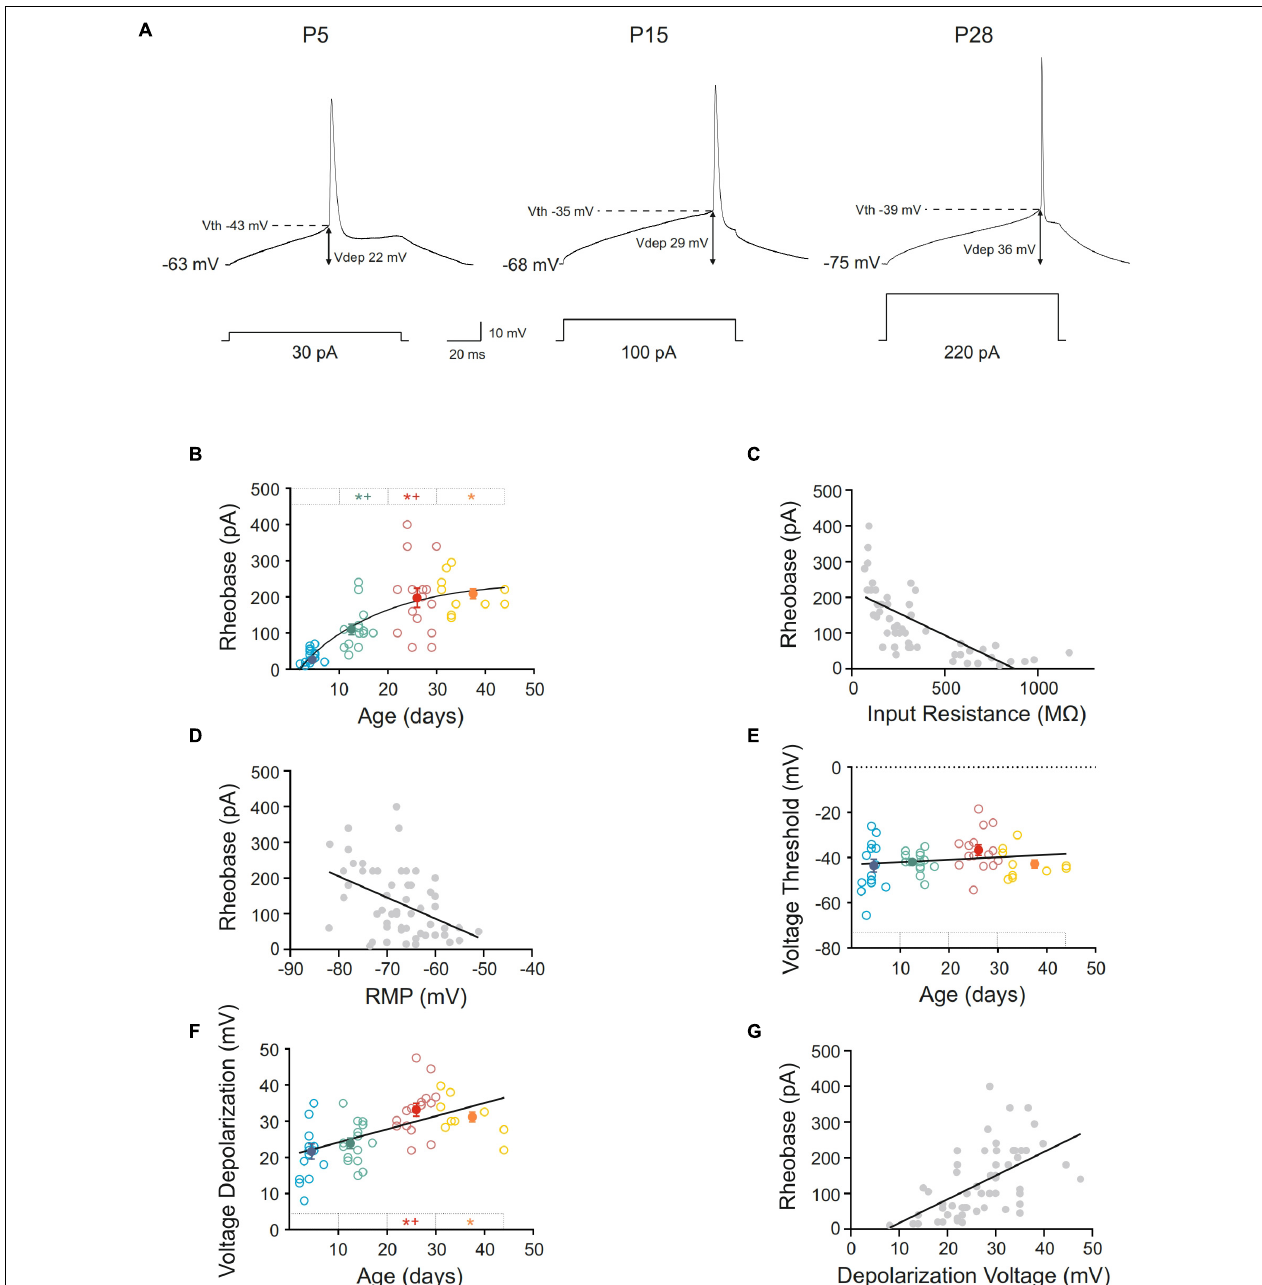
FIGURE 3 | Postnatal development of rheobase and threshold and depolarization voltages of motor cortex pyramidal neurons. (A) Membrane voltage responses to the minimum current (rheobase) required to evoke an action potential in representative neurons of different postnatal ages. (B,E,F) Scatter plots showing the changes in rheobase (B) , voltage threshold (E), and voltage depolarization (F) as a function of postnatal age. Open symbols represent the raw data, while filled symbols are the means of the four different age groups and their standard errors. Each group is represented by a color (blue = newborn, n = 15; green = infantile, n = 15; red = young adult, n = 15; yellow = adult, n = 10). An asterisk indicates a significant difference from the newborn group; a cross indicates a difference between adjacent groups. The significance level was established as p ≤ 0.05. (C,D,G) Correlation between rheobase and input resistance, r = –0.71; p < 0.0001 (C) , rheobase and RMP, r = –0.44; p < 0.0008 (D) and rheobase, and depolarization voltage, r = 0.56; p < 0.0001 (G) .